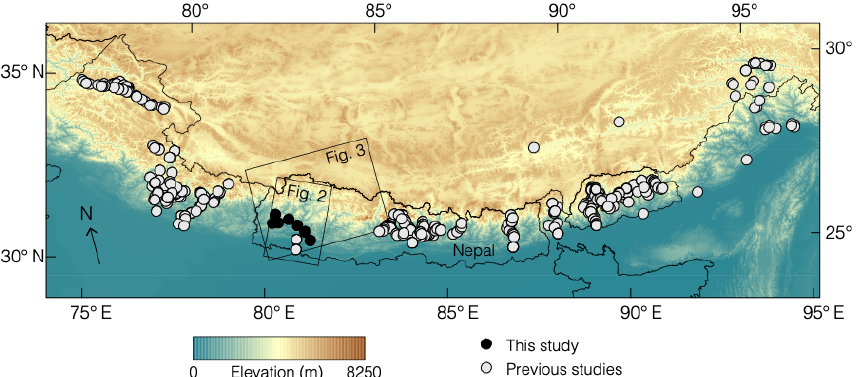
Figure 1. The relative paucity of denudation rate measurements in western Nepal is shown by the sampling locations of basin-averaged denudation rates inferred from cosmogenic nuclide measurements in previous studies (gray circles; Vance et al., 2003; Wobus et al., 2005; Finnegan et al., 2008; Godard et al., 2012, 2014; Lupker et al., 2012, 2017; Munack et al., 2014; Puchol et al., 2014; Scherler et al., 2014; West et al., 2014; Morell et al., 2015, 2017; Olen et al., 2015, 2016; Portenga et al., 2015; Dietsch et al., 2015; Le Roux-Mallouf et al., 2015; Abrahami et al., 2016; Adams et al., 2016; Kim et al., 2017; Dingle et al., 2018). Sampling locations of new denudation rate measurements in Far Western Nepal in this study are shown as black circles. Background colors show elevation in SRTM topographic data (Farr et al., 2007). Rectangles show the location of the swath profile in Fig. 2 and the study region in Far Western Nepal in Fig.